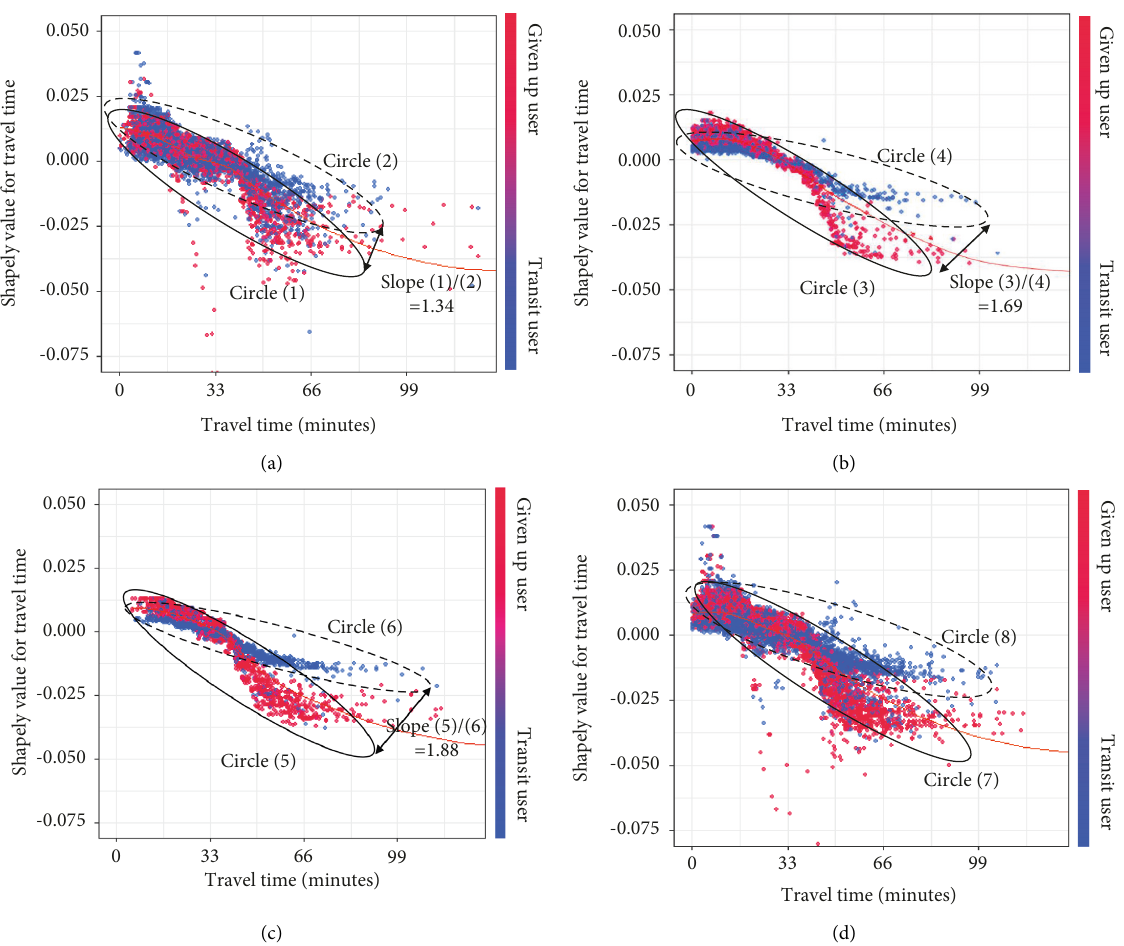
Figure 5: Result of feature dependency analysis. (a) Impact of travel time on subway users during COVID-19 pandemic. (b) Impact of travel time on bus users during COVID-19 pandemic. (c) Impact of travel time on both modes users during COVID-19 pandemic. (d) Overall impact of travel time on transit users during COVID-19 pandemic.